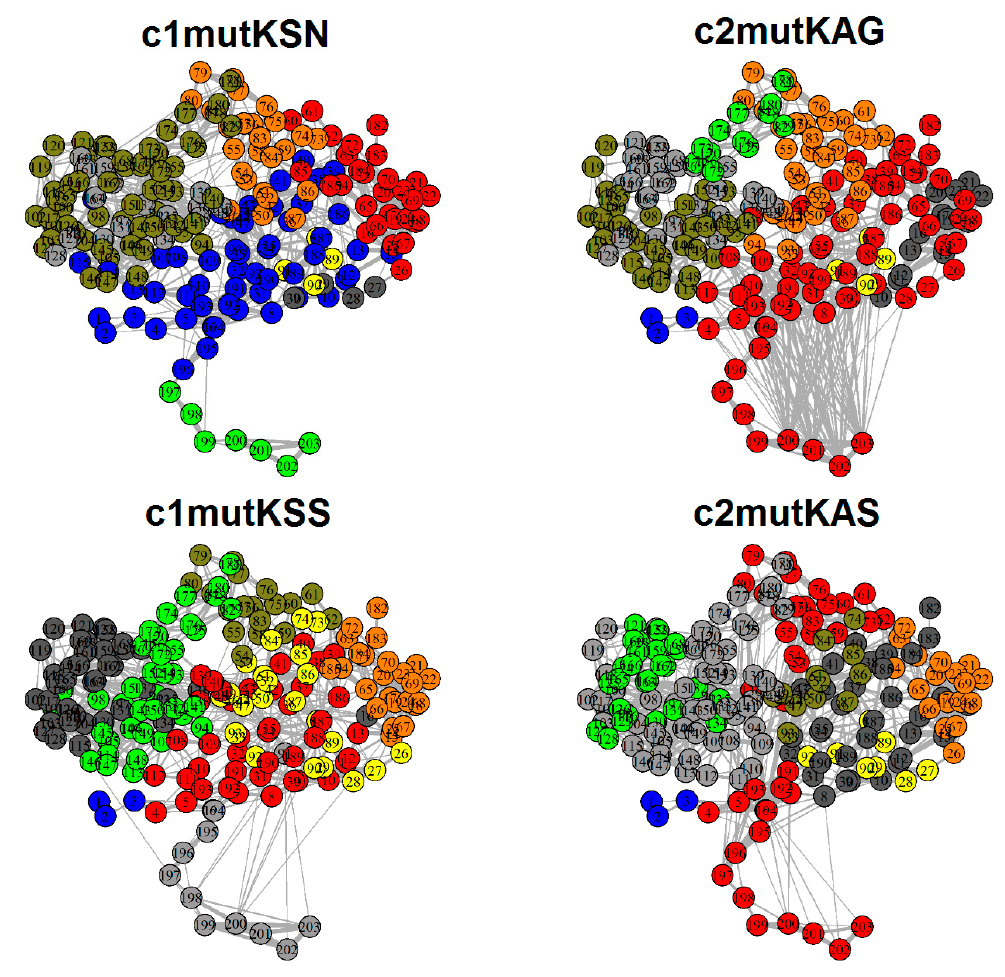
Figure 6. Community networks of the four HCV-1a clade systems. Correlation between NS3 residues and the terminal NS4A cofactor residues (197–203) is evidenced in the simulated clade II systems (red). These terminal cofactor residues form a single and separated community in the c1mutKSN (green) and c1mutKSS (grey) systems.